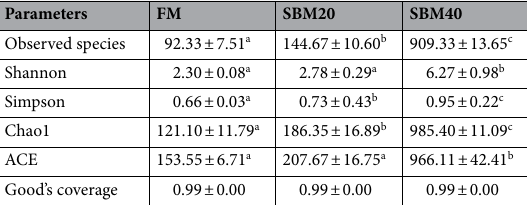
Table 6. Statistical analysis of alpha diversity of intestinal microflora (n = 3).